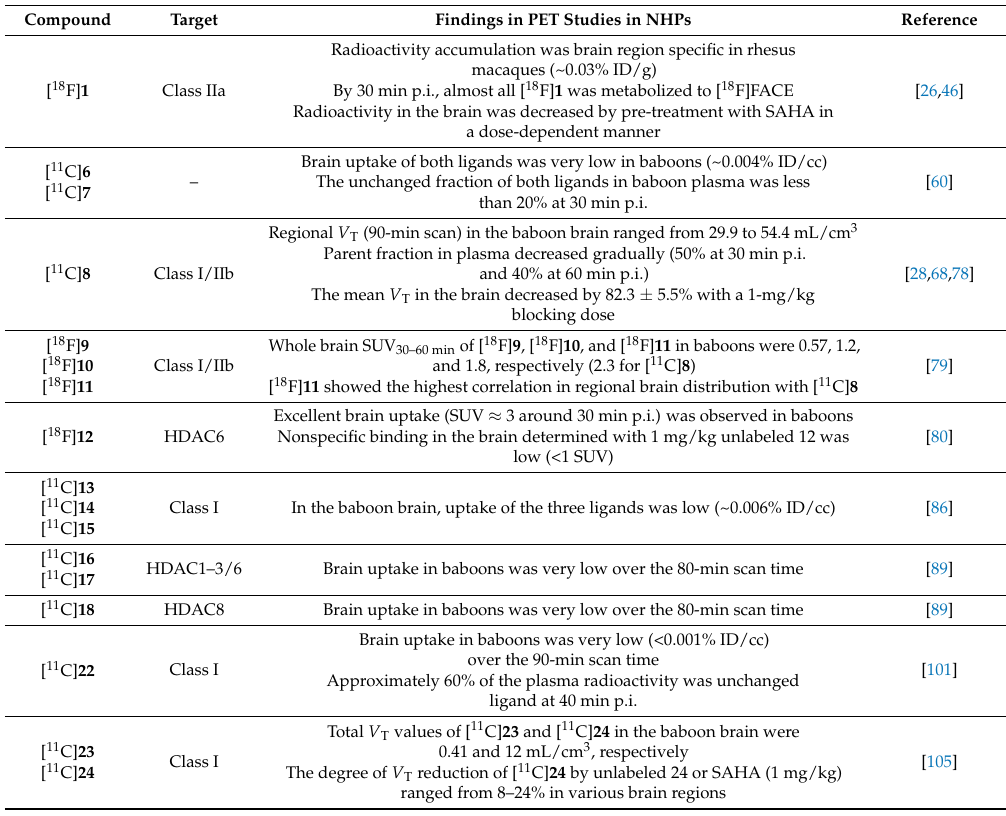
Table 5. Brain PET imaging studies of HDAC radioligands in